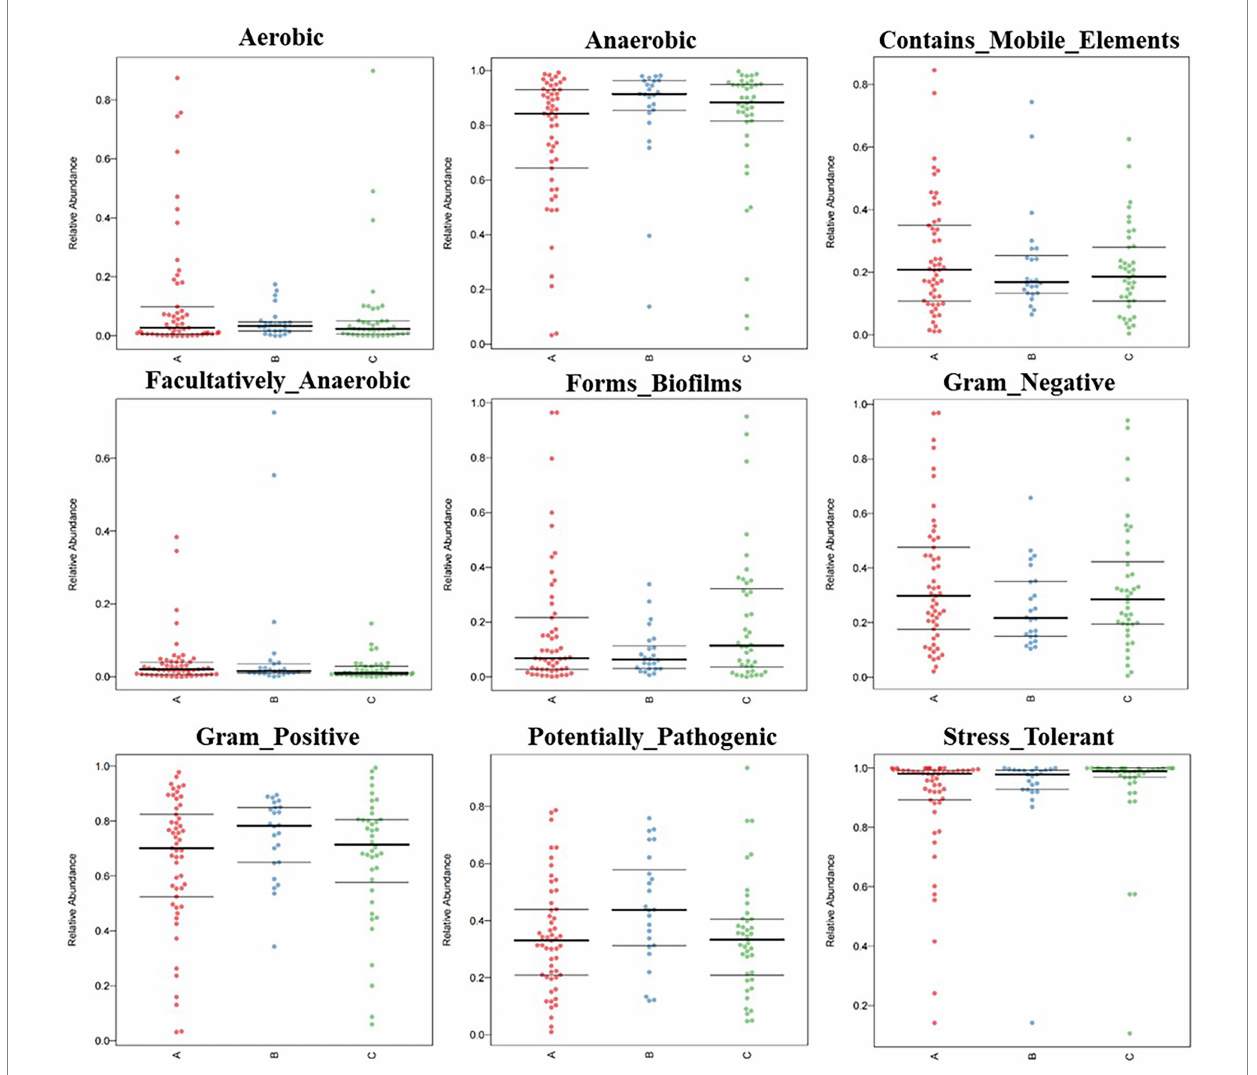
FIGURE. 2 BugBase feature prediction included aerobic, anaerobic, contains mobile element content, facultative anaerobic, potential pathogenicity, forms biofirms, gram-negative, gram-positive, potentially pathogenic, and stress tolerance